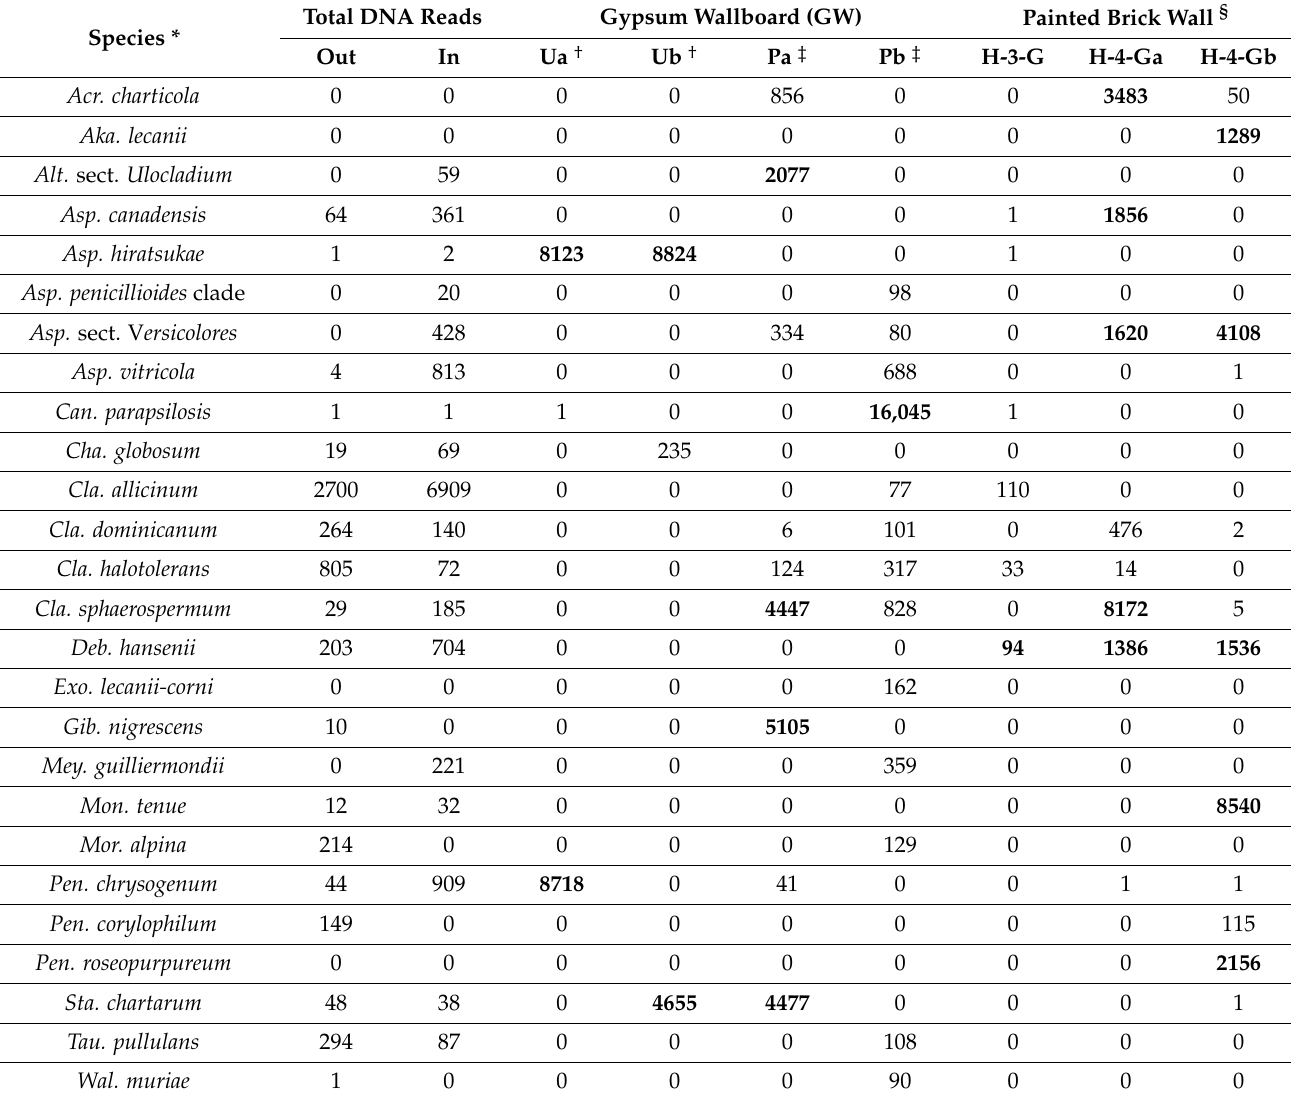
Table 4. Culture-independent identification. The most abundant fungal species growing on humid gypsum compared to humid brick wall and the total reads for the different OTUs out and in. High occurrences on building materials compared to total OTUs indoors and outdoors in